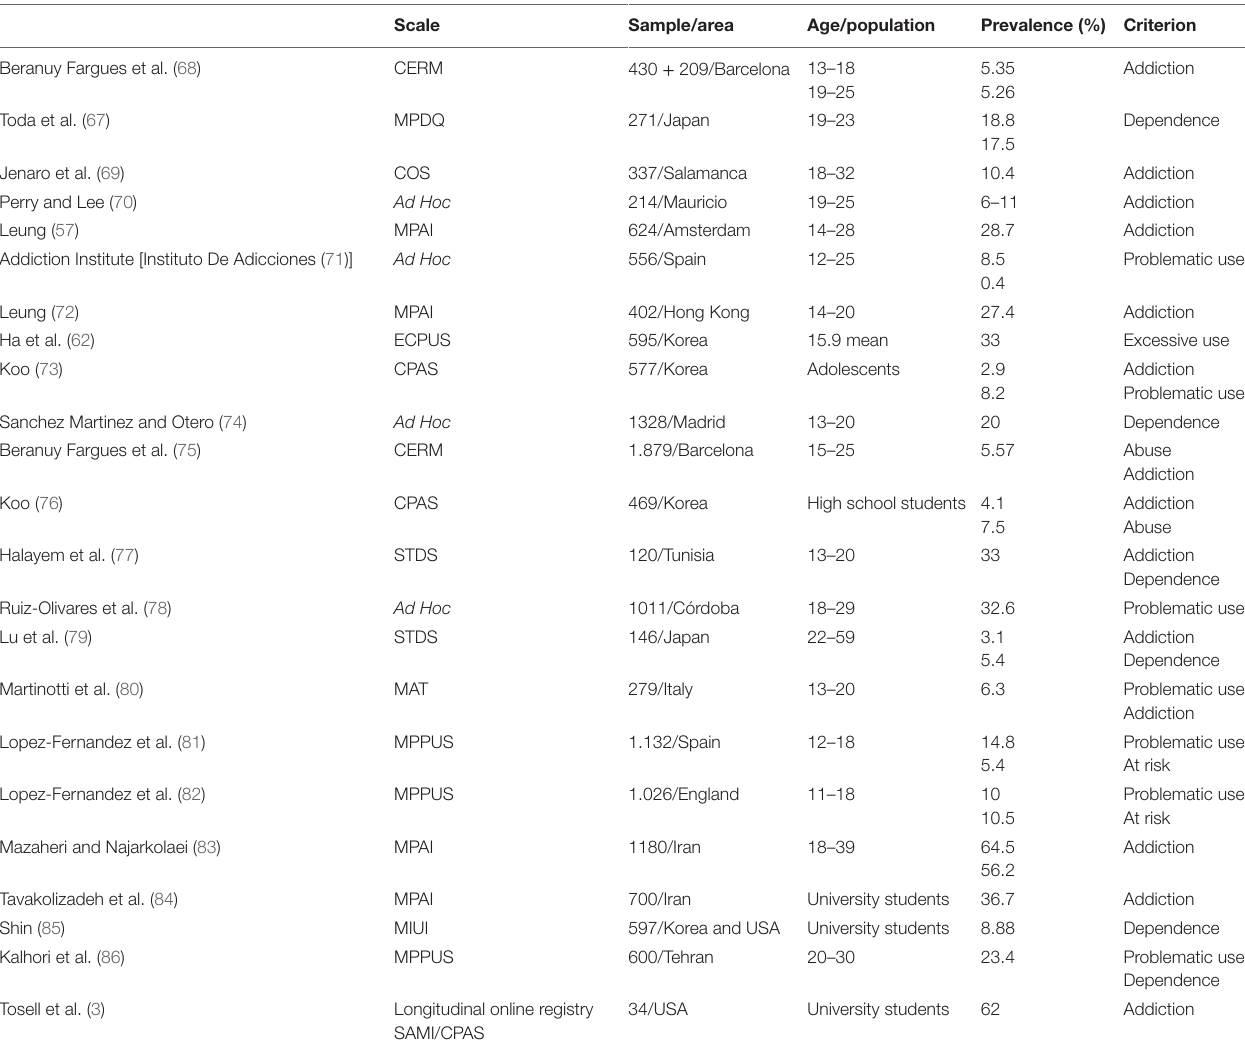
TABLe 2 | Prevalence